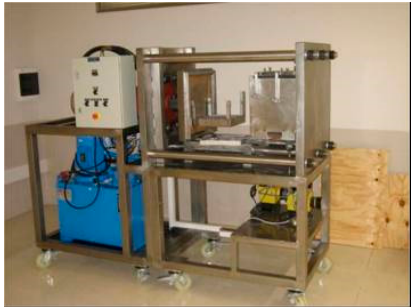
Figure 4. RockTestCO 2 test